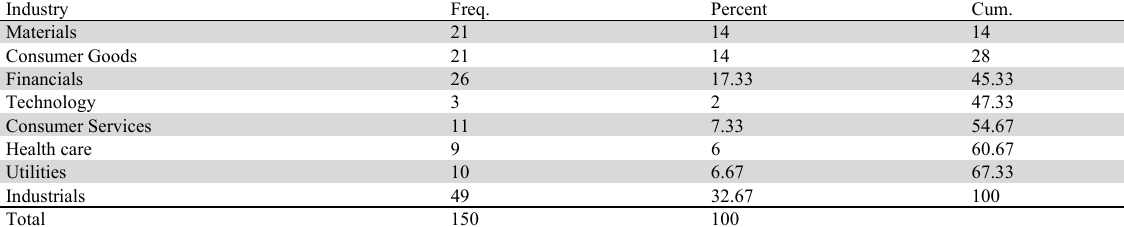
The distribution of industries in the sample Industry